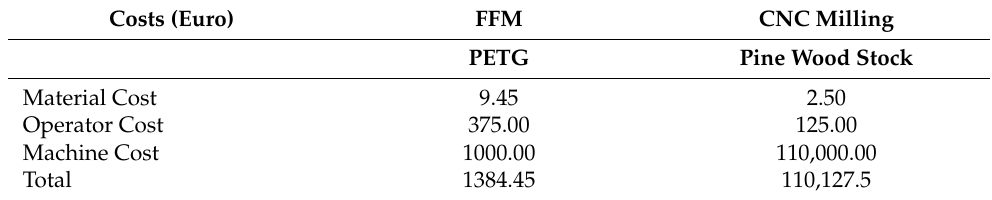
Table 3. Comparison of costs of CNC milling and FFF for the production of a column of the 17th- century tabernacle.